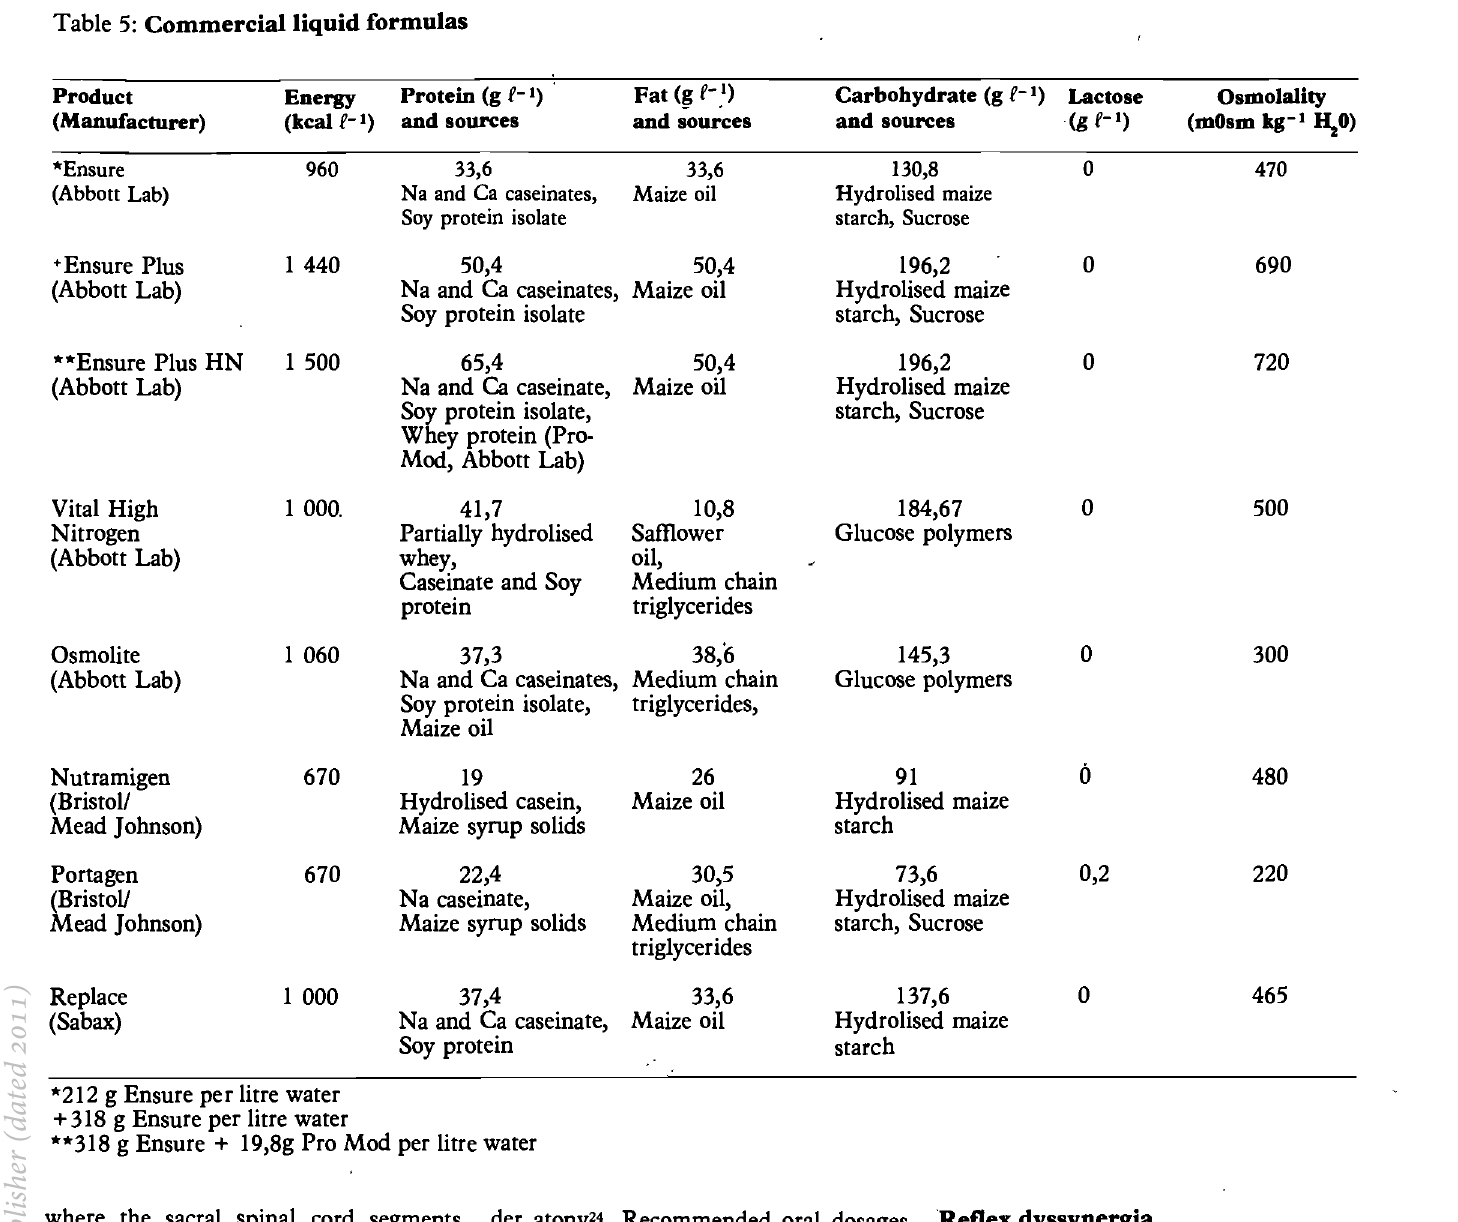
Table 5: Commercial liquid